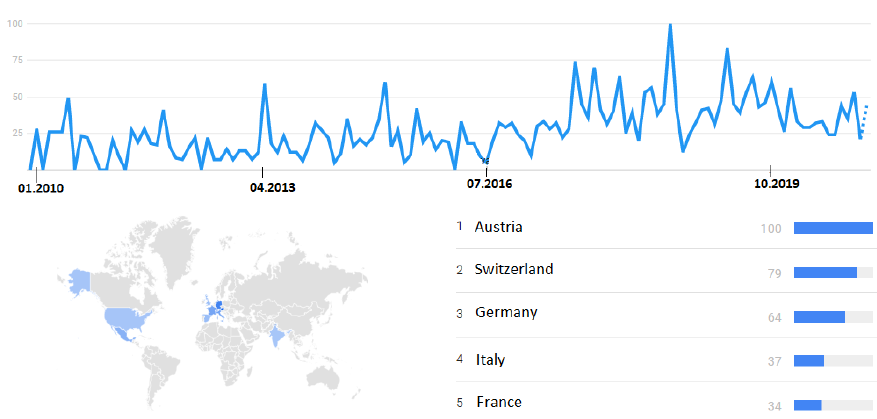
Figure 8. Global trend of interest in the term “intralogistics” (concerns the period 1 Jan 2010–12 Jan 2021).